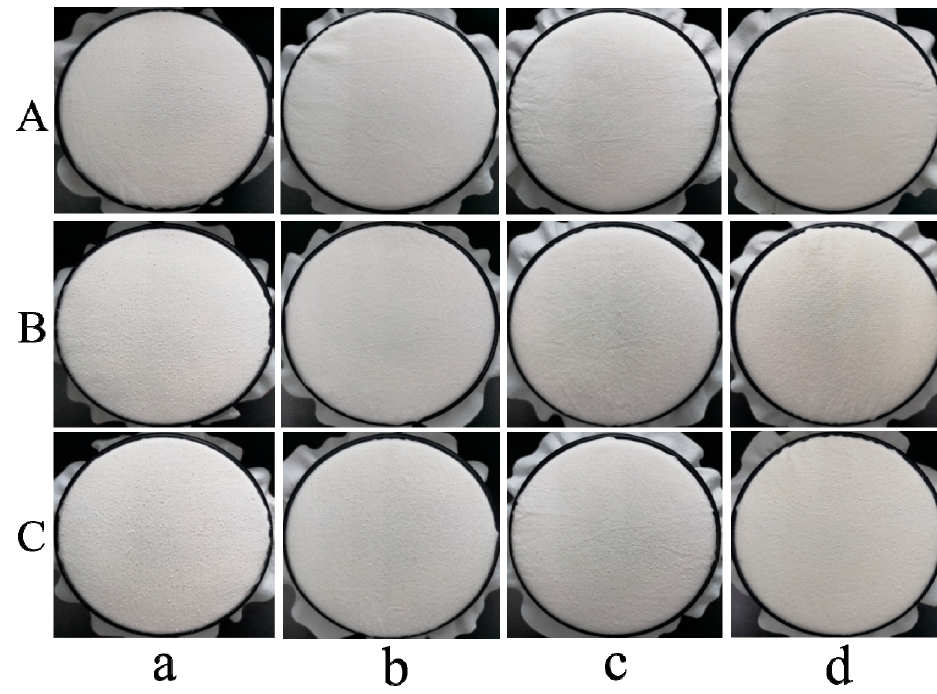
Figure 6. Surface morphology of ( a ) control cotton fabric; ( b ) TLP-modified cotton fabric; ( c ) DMP-modified cotton fabric; ( d ) ADP-modified cotton fabric ( A . before washing; B . after 5 washing cycles; C . after 10 washing